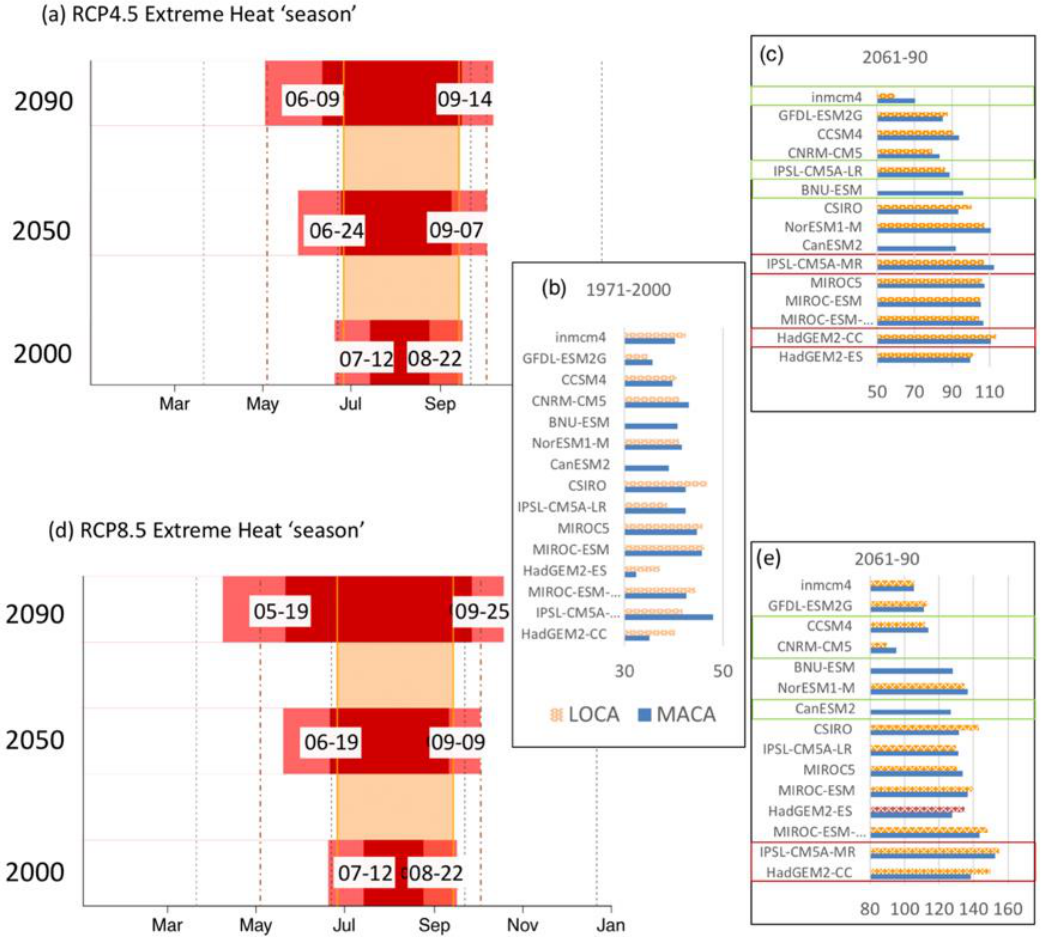
Figure 5. Horizontal bar plot of CD5’s100 ◦ F season for historical simulations (bottom bar plot in ( a , d )) and future climate model projections ( a ) RCP4.5 and ( d ) RCP8.5. For ( a , d ), the y-axis is the 30-year period ending in the year shown. The red bar spans the multi-model average onset and end, with dates shown in text (month-day). The pink areas depict the model spread as the 5th percentile (onset date) and 95th percentile (end date). The shaded vertical box denotes the duration of the 2011 100 ◦ F season for CD5, and the dashed-dot lines represent the average duration of the 100 ◦ F season for present-day Phoenix, AZ, USA. The right panels show ( b ) the length of the 100 ◦ F season (in days) for all models and SD datasets during the historical period, and the late 21st century for both ( c ) RCP4.5 and ( e ) RCP8.5. Green (red) boxes highlight the WW and HD models, respectively. Models are ordered by the magnitude of their average temperature increase between historical and late 21st century reference periods from smallest (top), to greatest change (bottom).